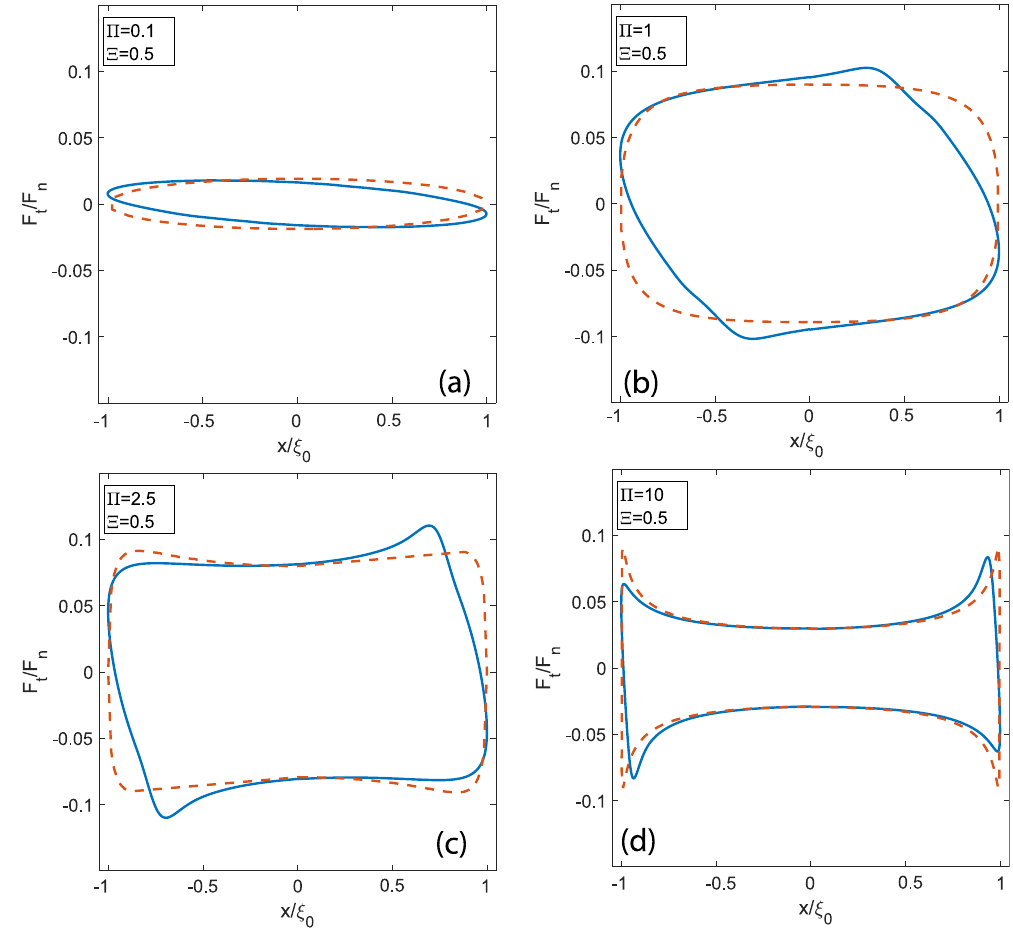
Figure 6. The dimensionless tangential force F t / F n as a function of the dimensionless abscissa for several values of Π and Ξ = 0.5. Blue lines refer to results obtained by means of the viscoelastic reciprocating approach, whereas red dotted lines are obtained employing a classic steady-state